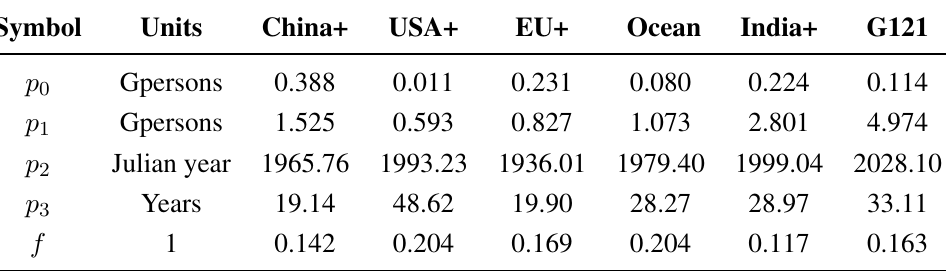
Table 6. Region dependent nitrous oxide